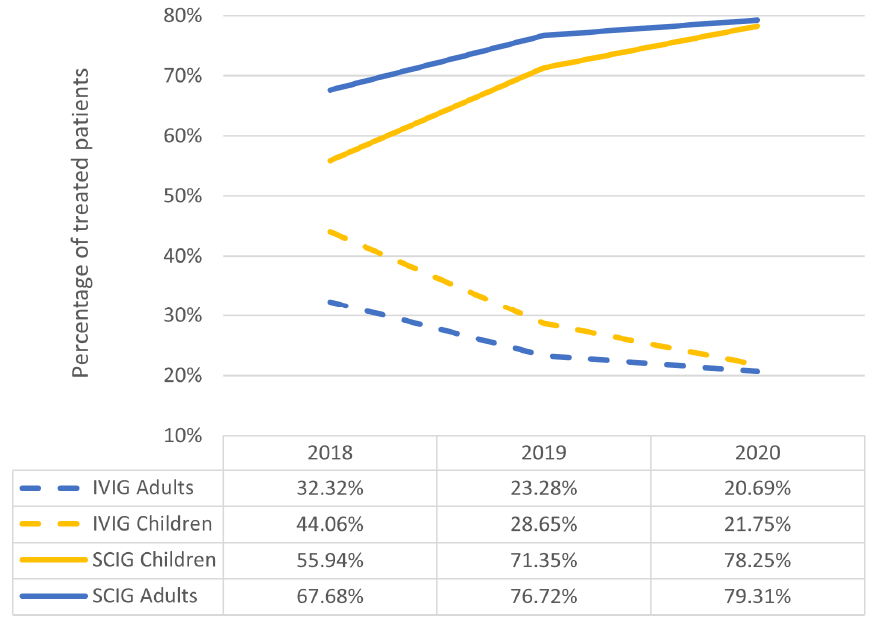
Figure 4. The proportion of patients treated through SCIG and IVIG in primary deficiency drug programs in adults and children.